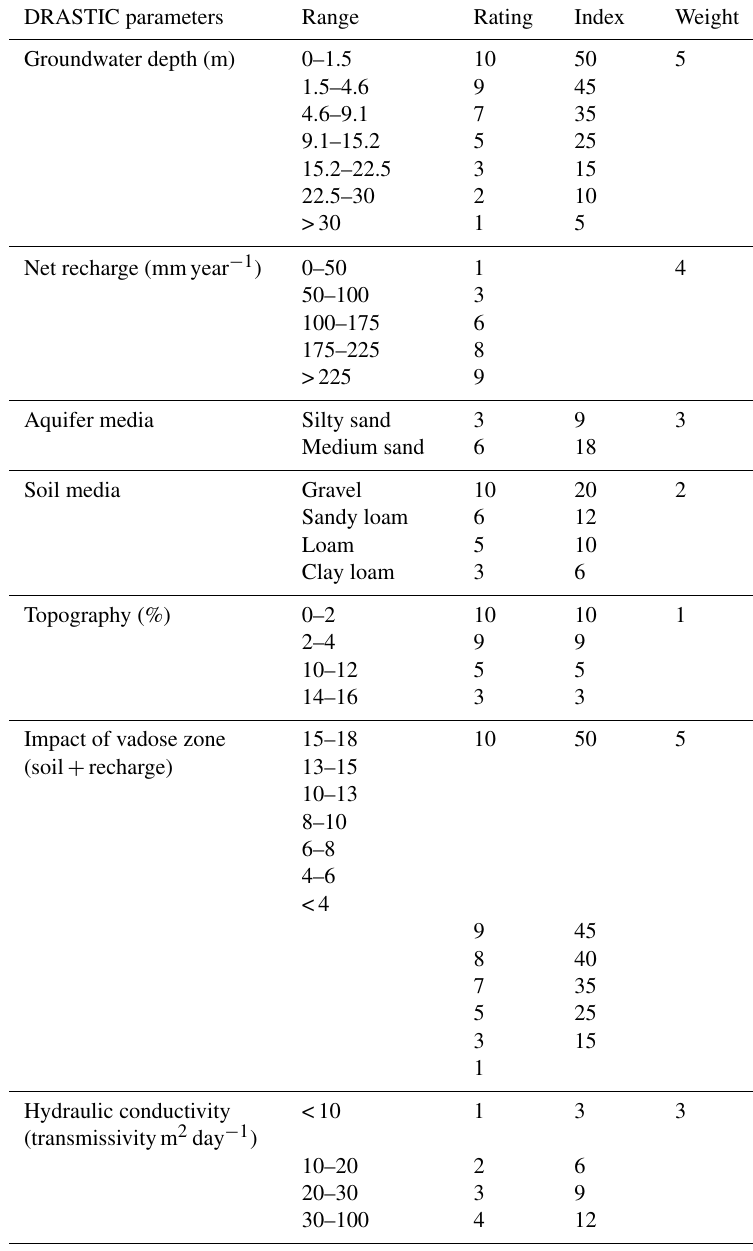
Table 8. DRASTIC